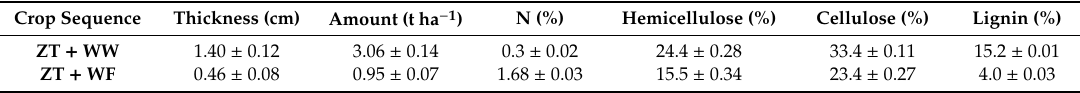
Table 1. Thickness (cm), amount (t ha − 1 ), nitrogen (N, %), hemicellulose (%), cellulose (%), and lignin (%) contents of durum wheat and faba bean residues under zero tillage (ZT) treatments (durum wheat residues: ZT + wheat monocropping (ZT + WW); faba bean residues: ZT + wheat-faba bean rotation (ZT + WF)). Means ± standard errors (over growing seasons) are